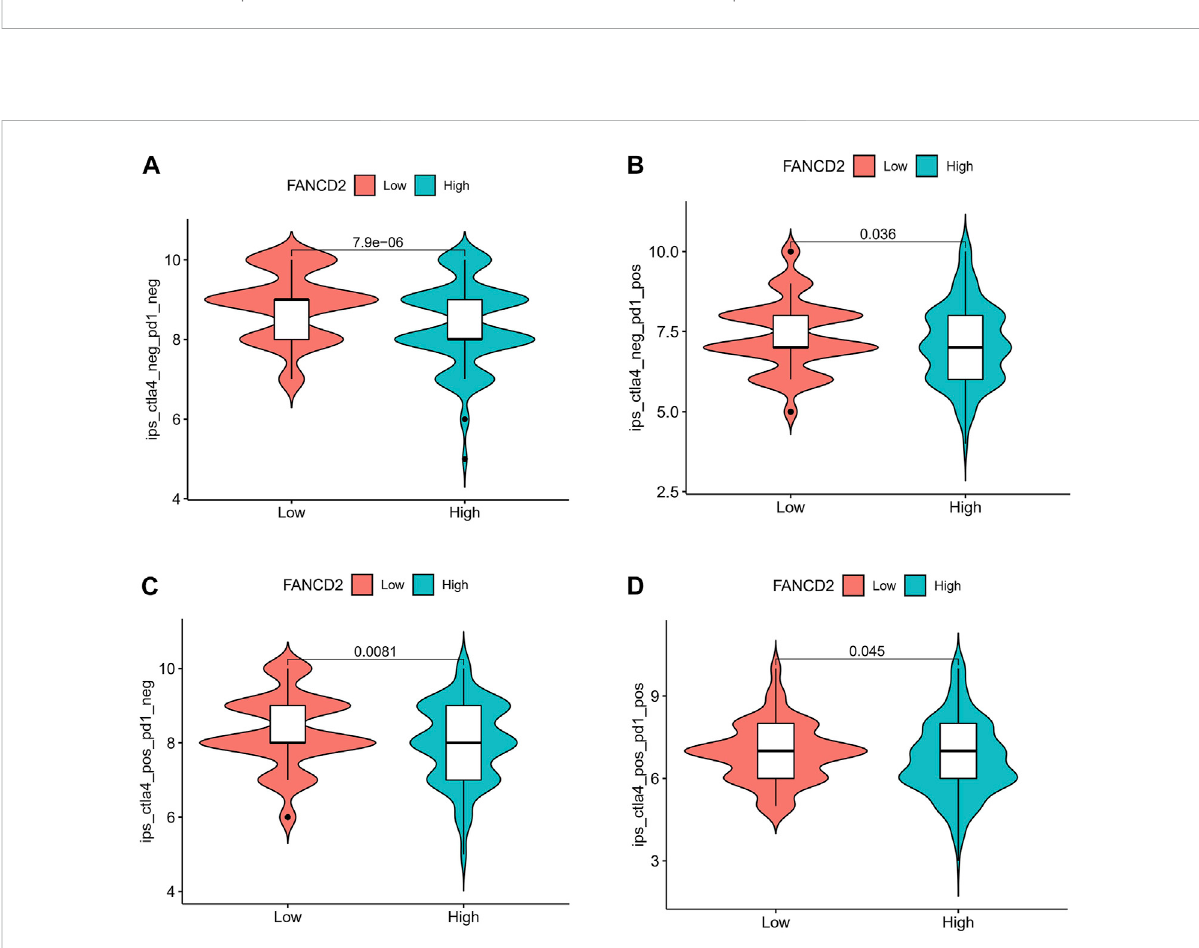
FIGURE 10 Correlation of FANCD2 expression with the immunophenoscore (IPS) in HCC. (A) ips_ctla4_neg_pd1_neg, (B) ips_ctla4_neg_pd1_pos,